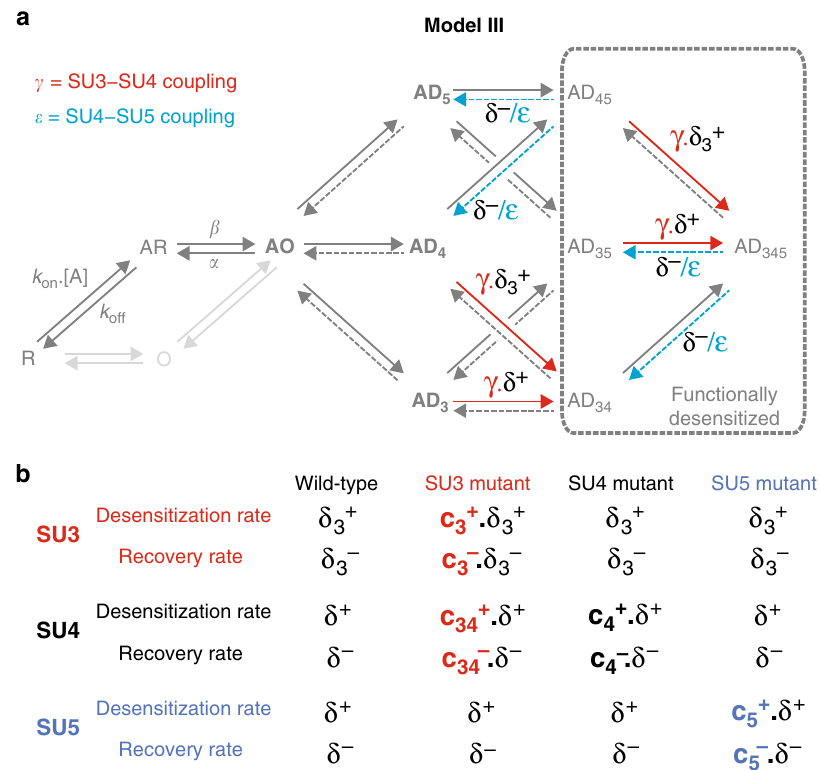
Fig. 6 Model III introduces inter-subunit coupling during desensitization. a For the wild-type receptors, Model III builds upon Model II by adding some coupling between adjacent subunits during desensitization. On the one hand, desensitization of SU3 accelerates the desensitization of SU4 by a factor γ , and reciprocally. On the other hand, desensitization of SU4 slows the recovery of SU5 by a factor ε , and reciprocally. b For mutated concatemers, Model III incorporates the additional hypothesis that the mutation of SU3 also affects the desensitization of SU4 by increasing both its desensitization and recovery rates, by ratios c 34 + and c 34 − ,